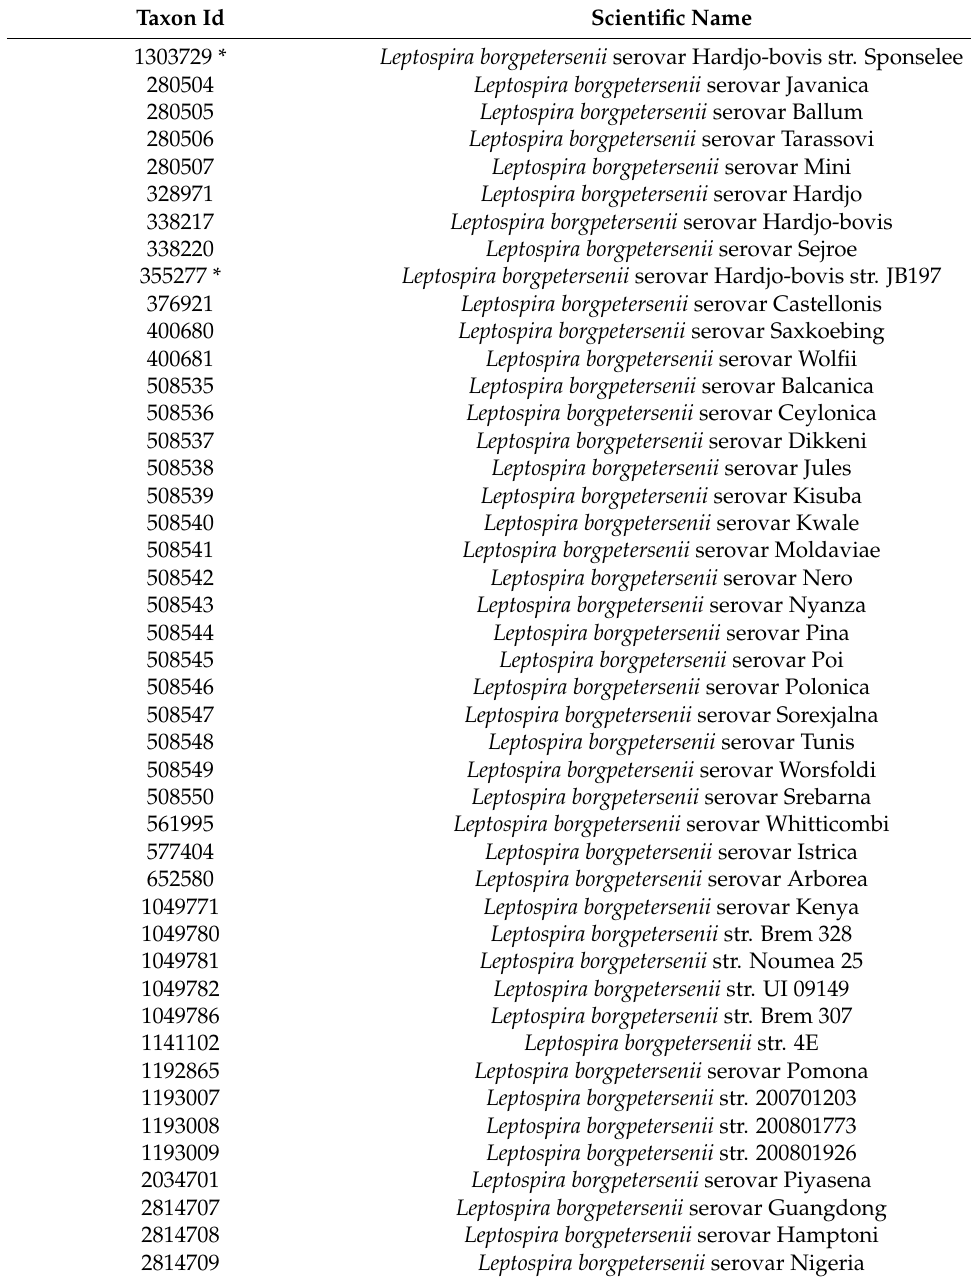
Table 3. List of taxon ID (NCBI) of L. borgpetersenii , with different